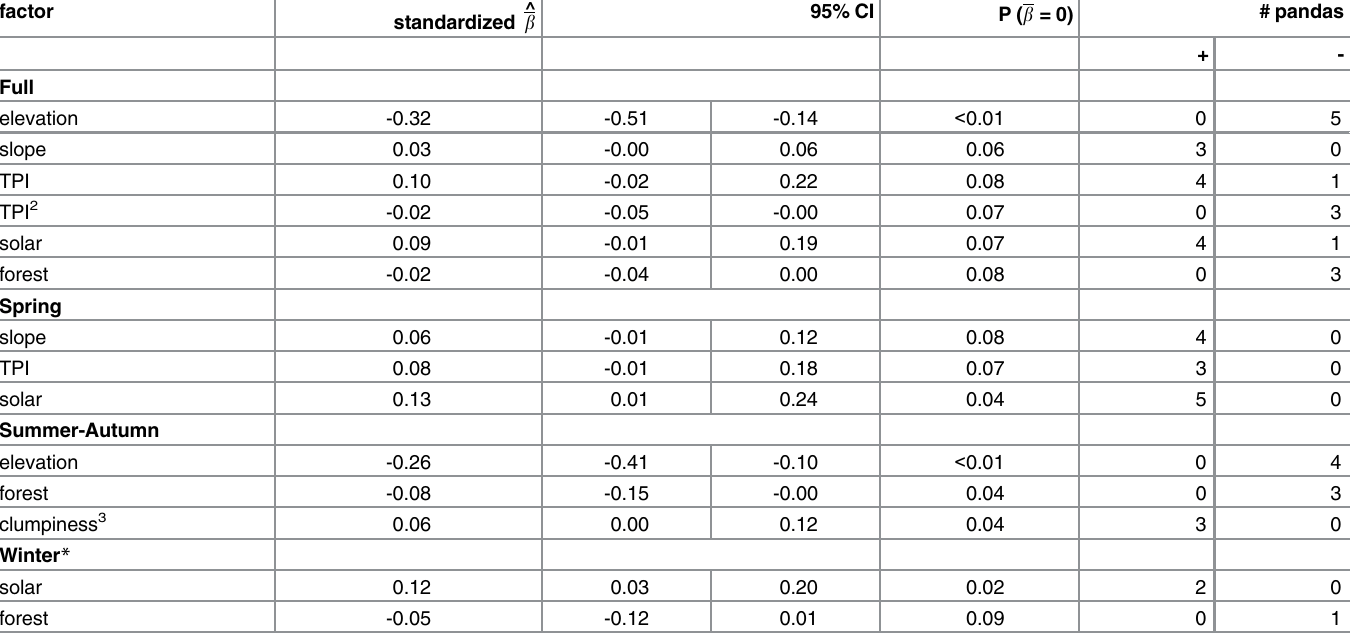
Table 2. Contribution of habitat variables to predicting giant panda habitat use across their utilization distributions (n = 5). Only significant variables are